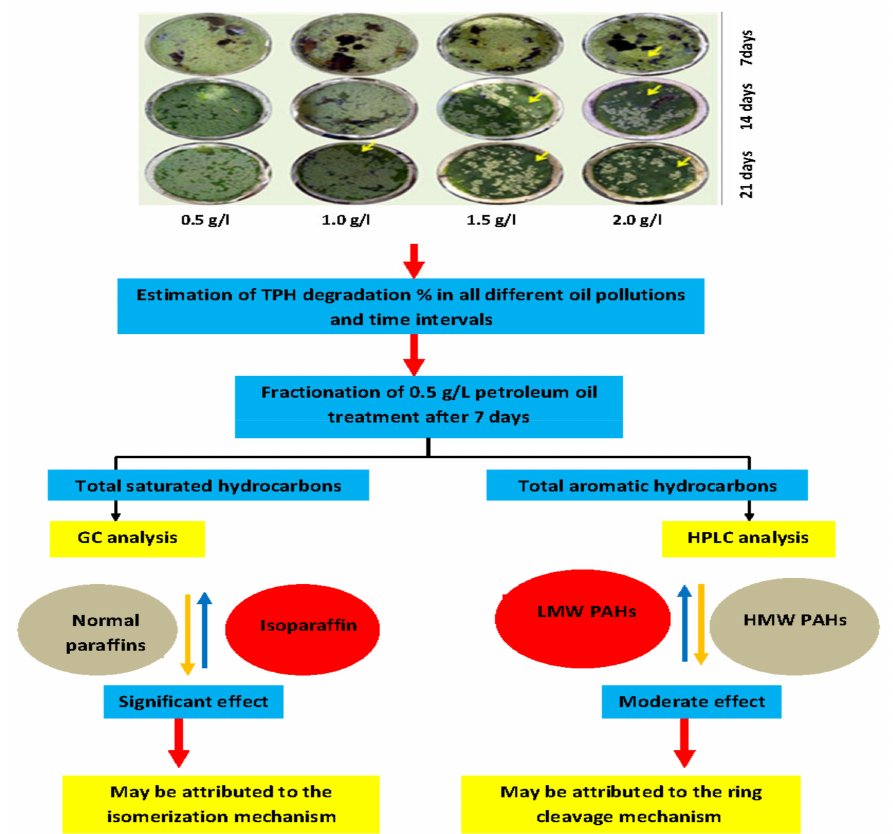
Figure 4. The effect of different pollution levels and exposure times on the bioremediation poten- tiality of the Azolla / Anabena combination and changes in the molecular type compositions of the remaining petroleum hydrocarbons at 0.5 g/L after a seven-day growth period. Abbreviations: TPH (total petroleum hydrocarbon), GC (gas chromatography), HPLC (high performance liquid chromatography), HMW PAH (high molecular weight polycyclic aromatic hydrocarbon) and LMW PAH (low molecular weight polycyclic aromatic